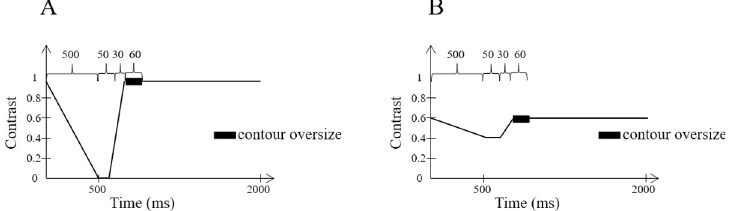
Fig 7. Contrast variation of the monocular element over a two-second period for the high contrast condition (A) and the intermediate contrast condition (B).